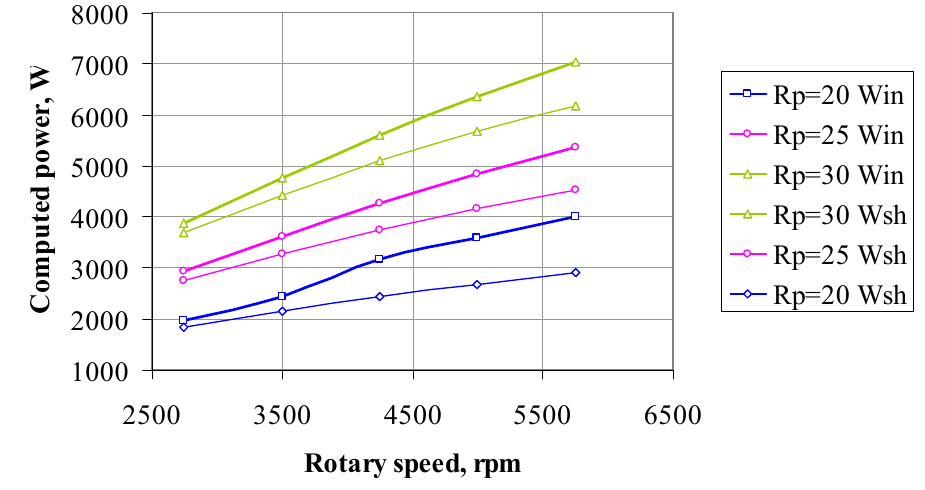
Figure 6. Evolution of the expander internal power output and shaft power at different pressure ratios and rotary speeds.